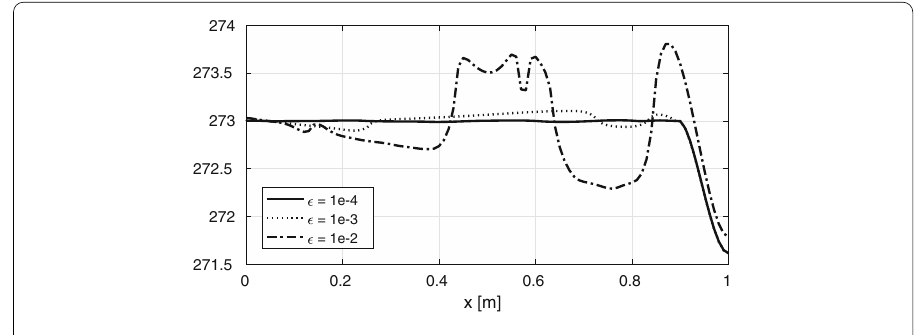
Fig. 11 Melting volume example: temperature profiles at 0 . 5 t f obtained from the proposed tolerance-based HI scheme for different tolerances (100 elements, (cid:11) t = 200s)